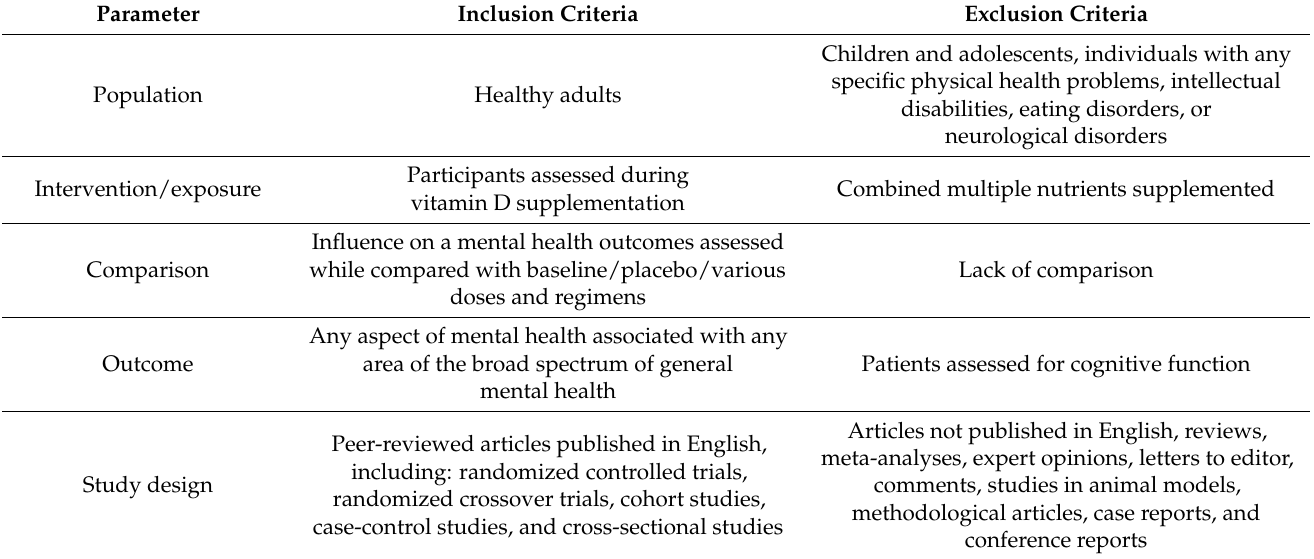
Table 1. Patient, intervention/exposure, comparator, outcome, study design (PICOS) criteria for inclusion and exclusion of studies.